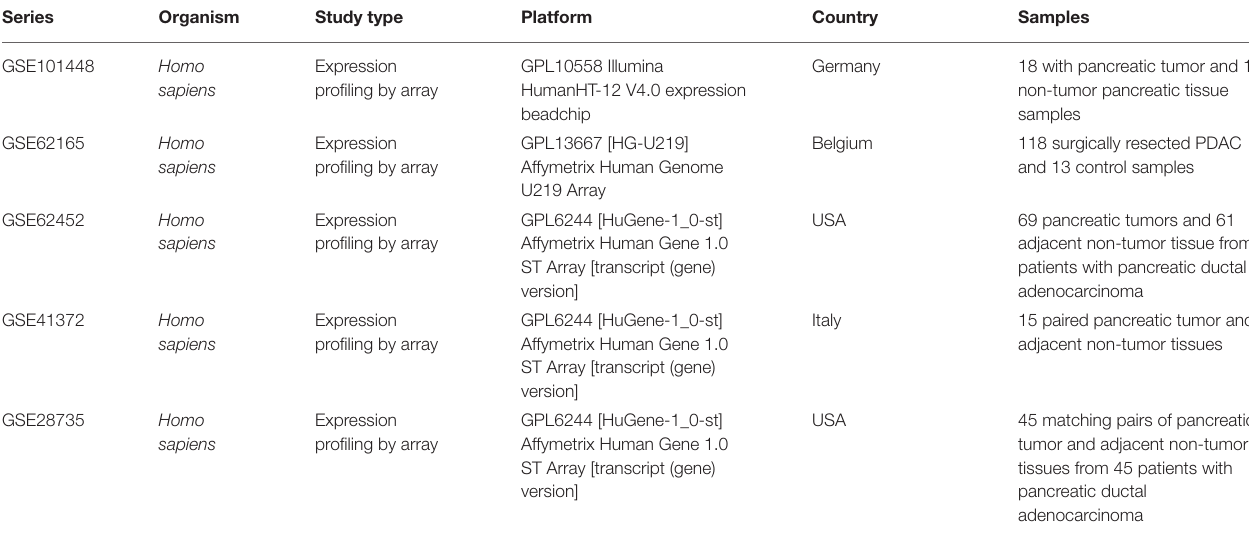
TABLE 1 | Detailed information of the five GEO data sets in the